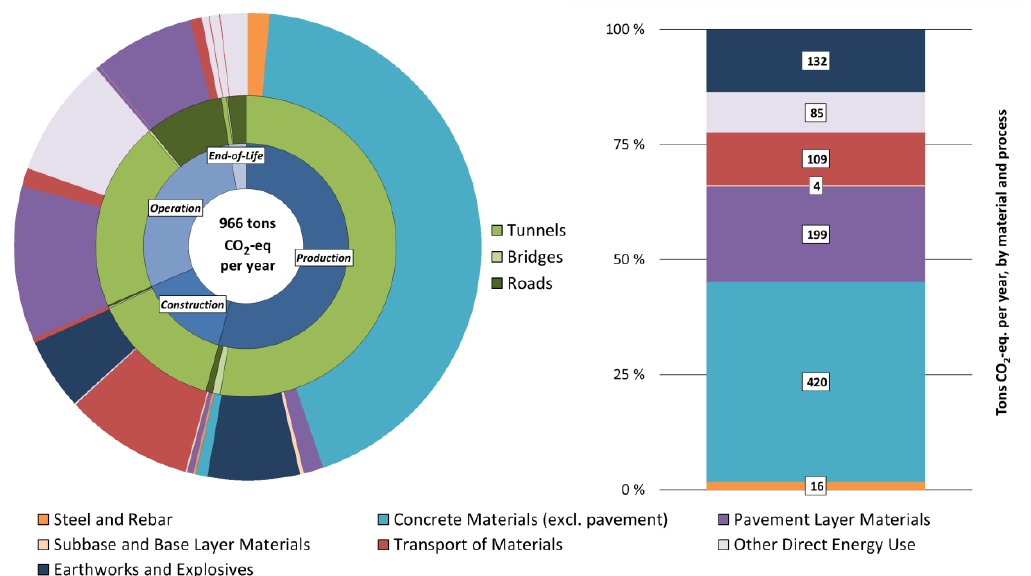
Figure 5. Contribution analysis for and greenhouse gas (GHG) emissions for Alternative